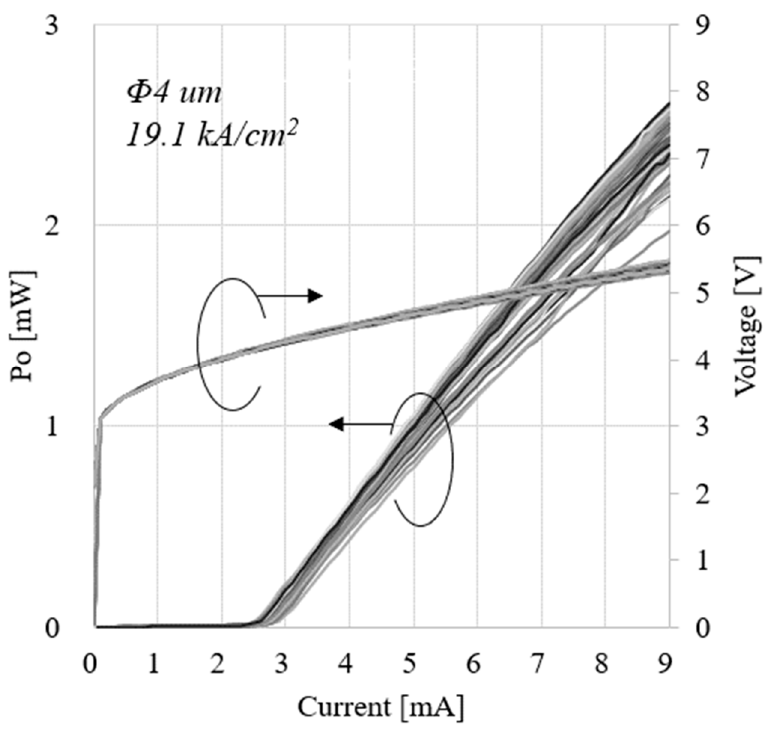
Figure 7. The I-V and I-L characteristics of curved mirror blue VCSELs. It contains data for 55 chips obtained from a wafer.